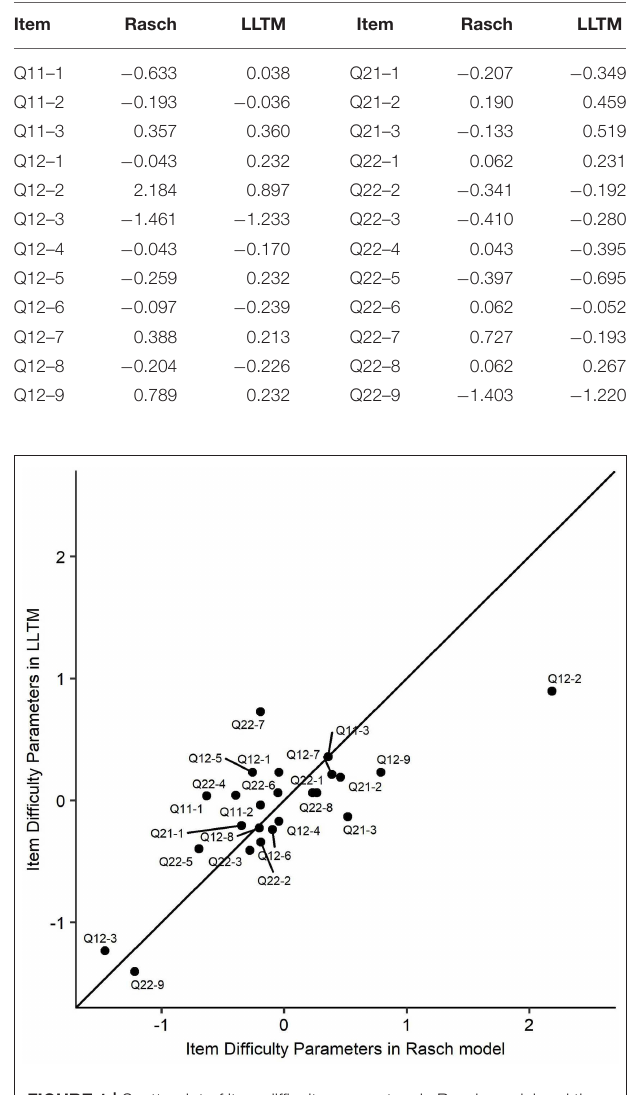
FIGURE 1 | Scatterplot of item difficulty parameters in Rasch model and the